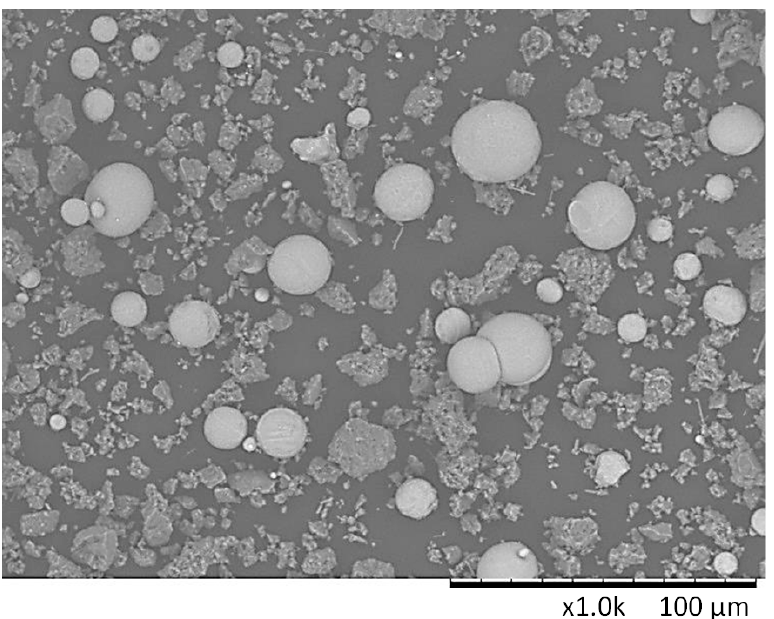
Figure 1. Histograms of Ti-( a ) and AlN –( b ) powders’ particle size distribution.